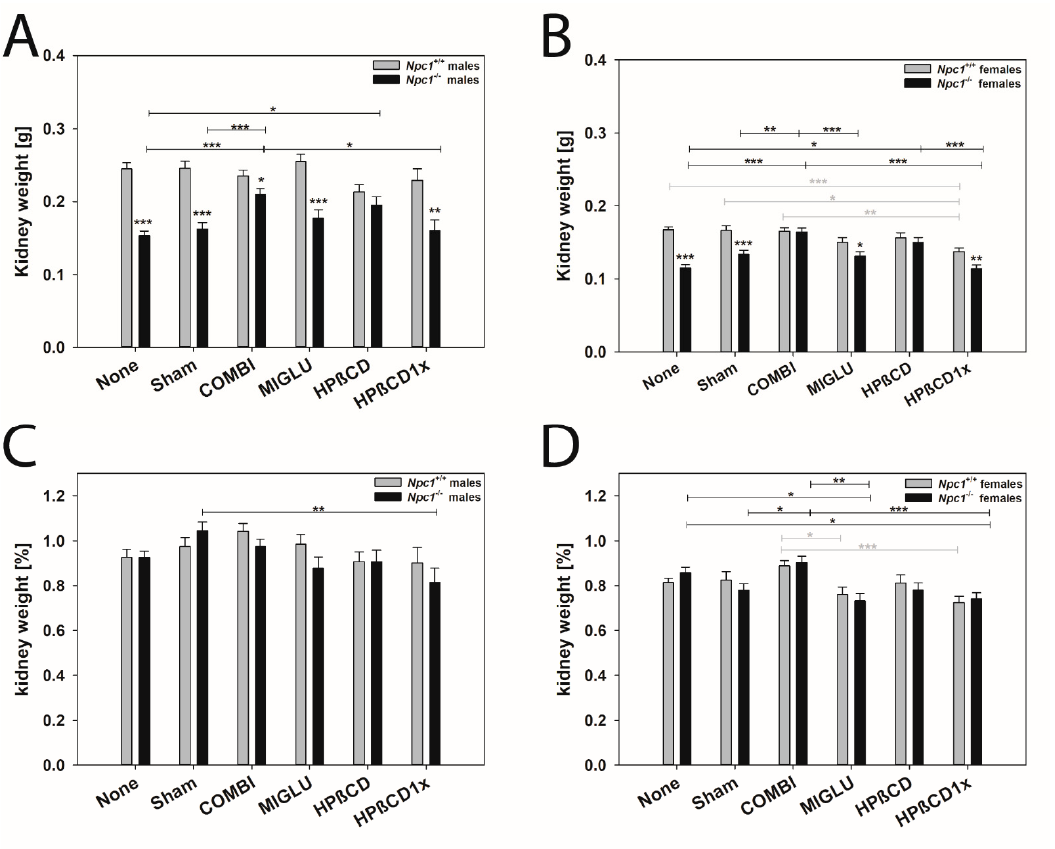
Figure 6. Kidney weight ( A , B ) and relative kidney weight ( C , D ) of Npc1 mice. Male ( A , C ) and fe- male ( B , D ) mice. Significant post-hoc tests are indicated by asterisks (* p < 0.05, ** p < 0.01, *** p < 0.001). Data are means ± SEM.